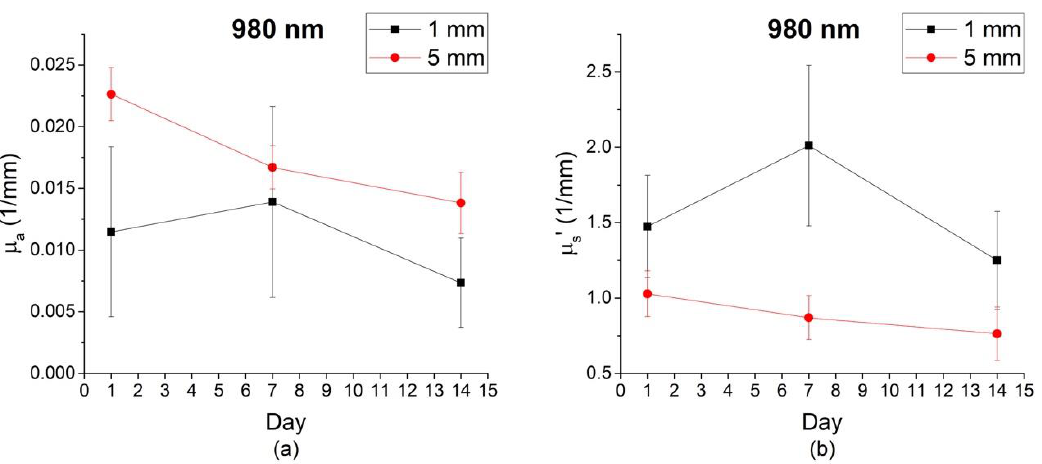
Figure 6. ( a ) Absorption and ( b ) reduced scattering coefficients of an apple recovered at a wavelength of 980 nm at source–detection separation (SDS) of 1 mm (black squares) and 5 mm (red circles) 1, 7, and 14 days after purchase.